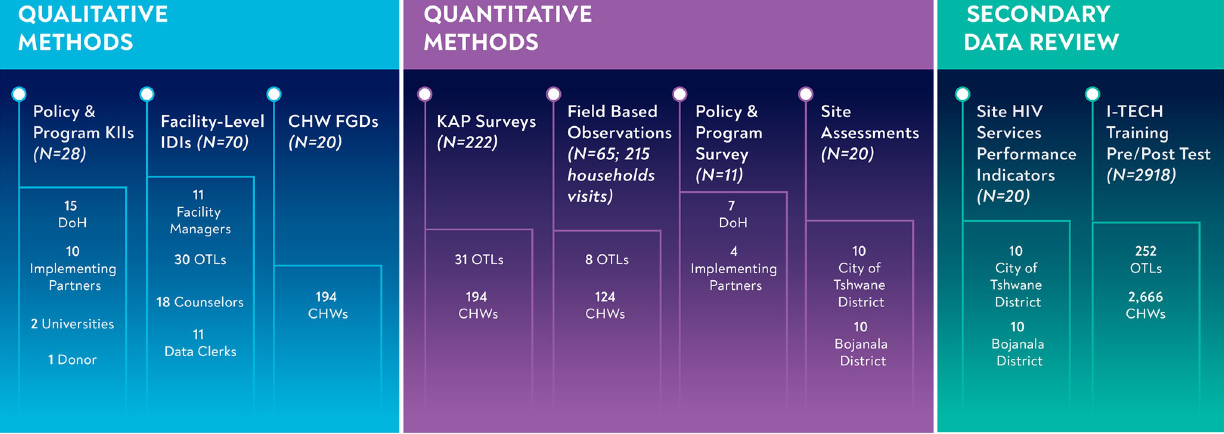
Fig 2. Sample size for each data collection method. KIIs = Key Informant Interviews DoH = Department of Health IDIs = In-depth Interviews CHWs = Community Health Workers FGDs = Focus Group Discussions KAP = Knowledge, Attitudes and